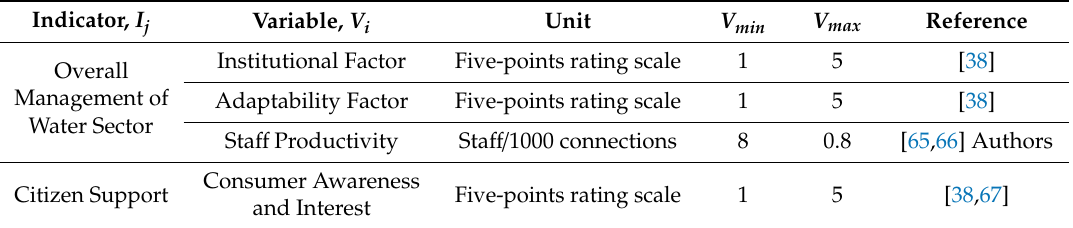
Table 6. Benchmarking variables for society and governance